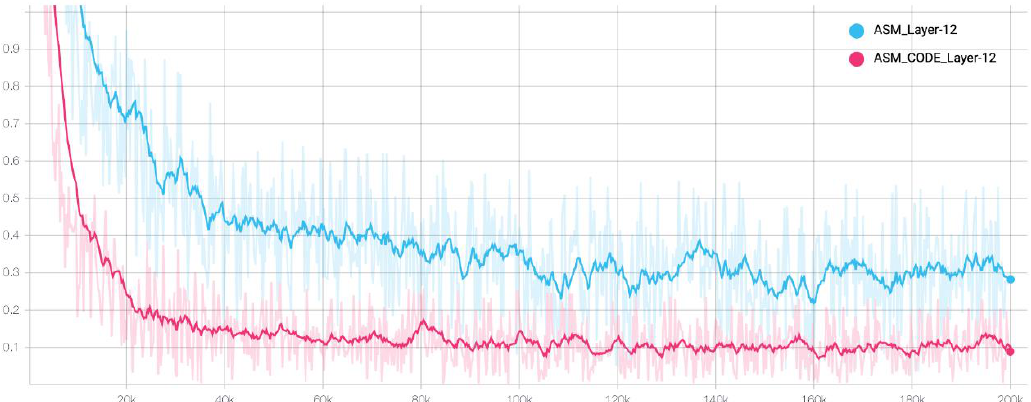
Figure 4. Comparison of training loss gradient curves for the ASM with Arabic numeric code replacement and without replacement, where the curve smoothness is set to 0.7, and the opaque curve is after the smoothing setting and the translucent curve is the original loss gradient curve. Table 5. The prediction accuracy of the ASM and the ALM in the validation datasets.